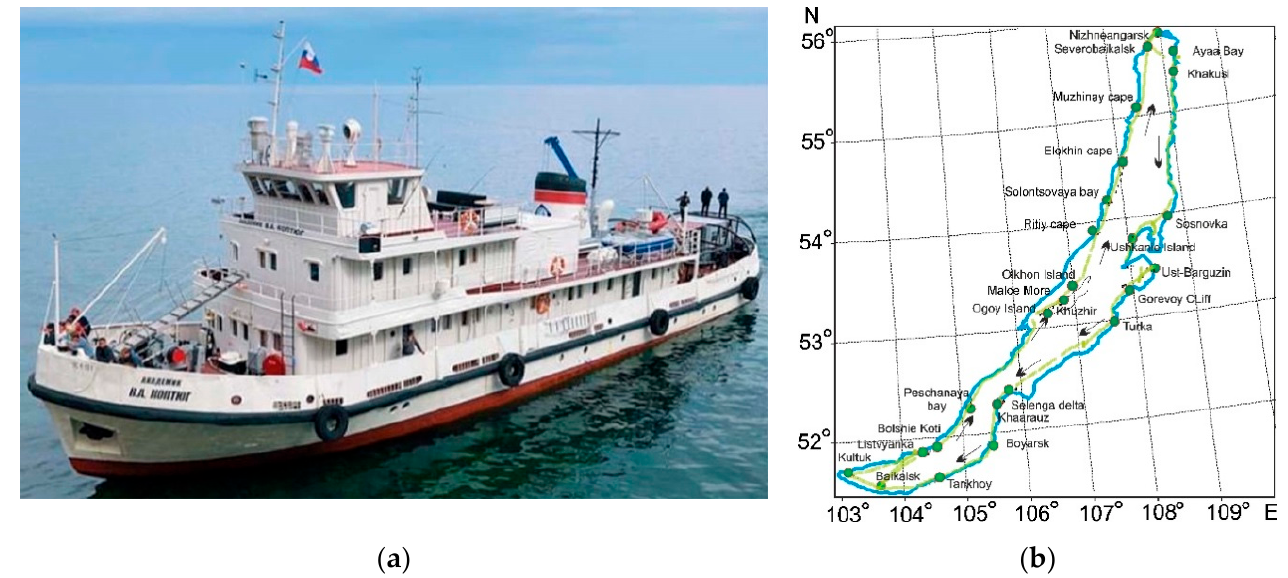
Figure 1. The scientific research vessel “Akademik V.A. Koptyug” ( a ); schematic map of the vessel’s route ( b ).